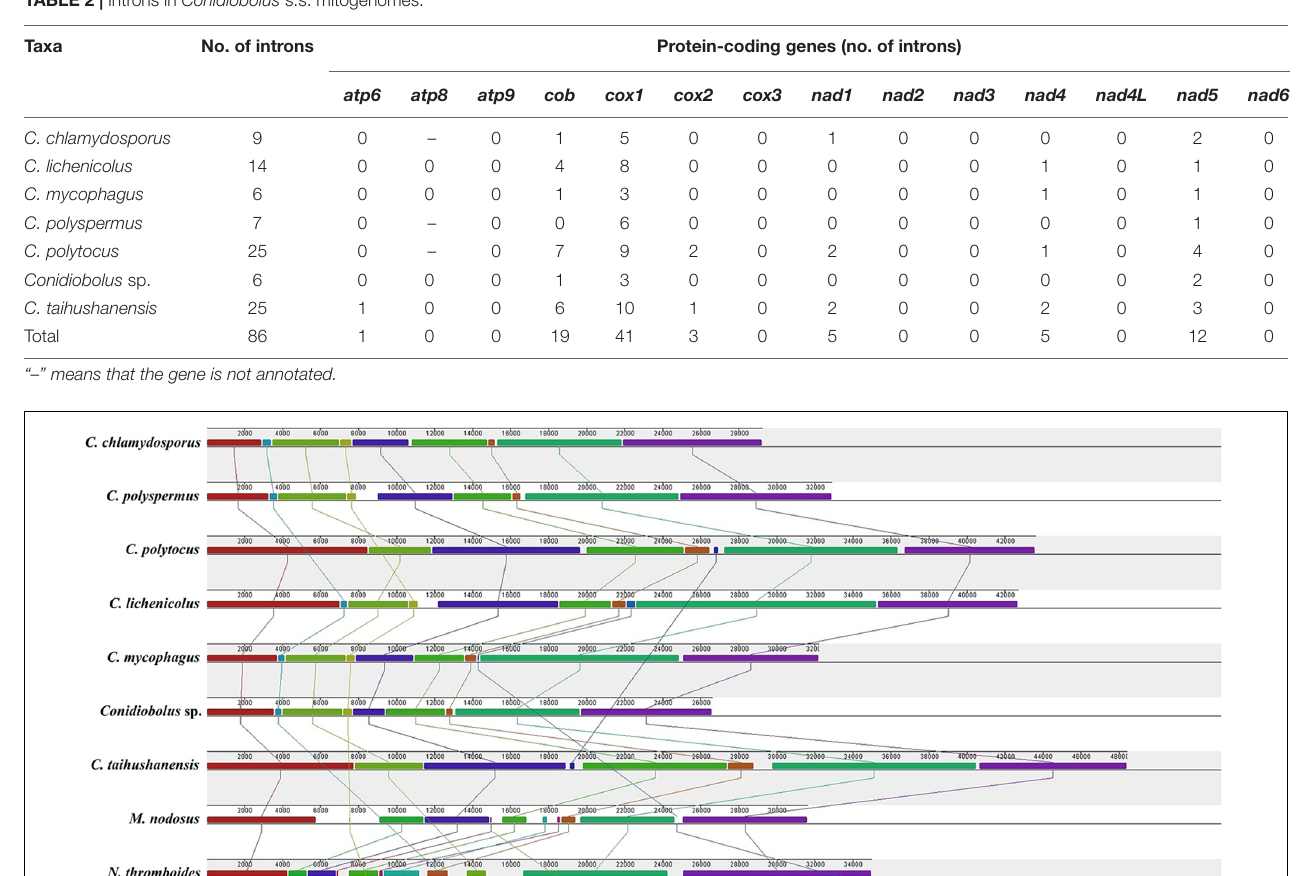
TABLE 2 | Introns in Conidiobolus s.s. mitogenomes.